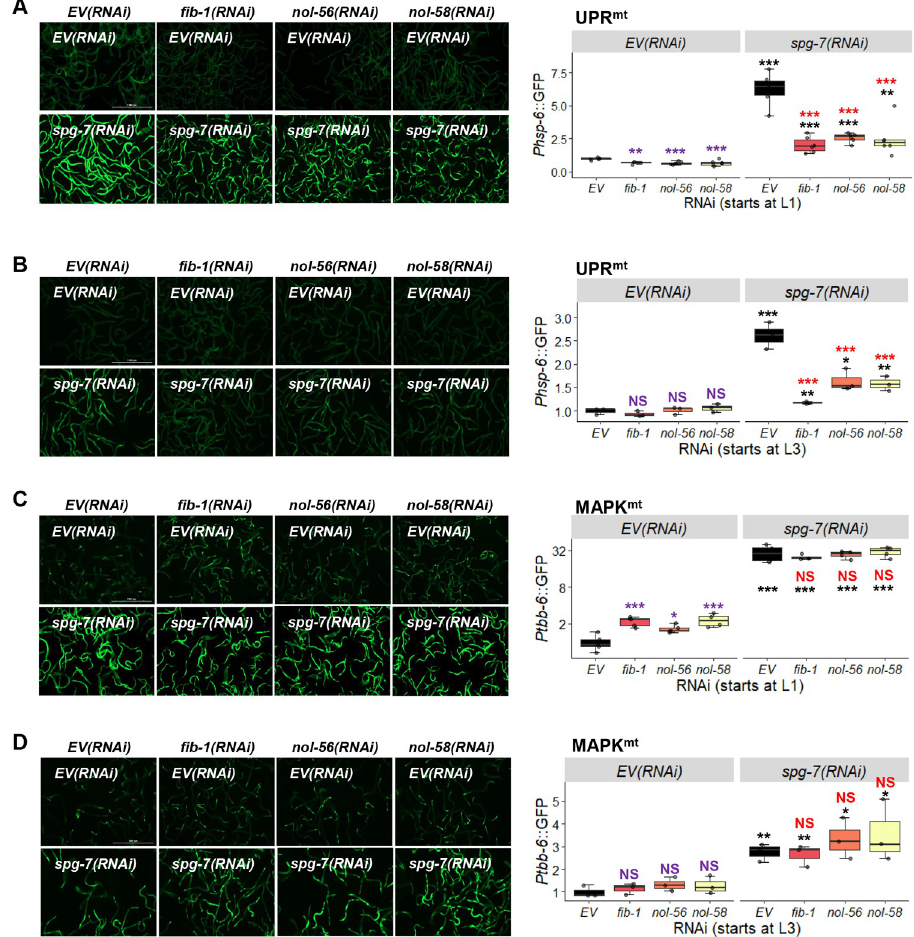
Fig 2. Box C/D snoRNP knockdown reduces UPR mt but increased MAPK mt expression. (A-D) Fluorescent images (left) and quantification of GFP fluorescence (right) of C . elegans carrying Phsp-6 ::GFP (A, B) or Ptbb-6 ::GFP (C,